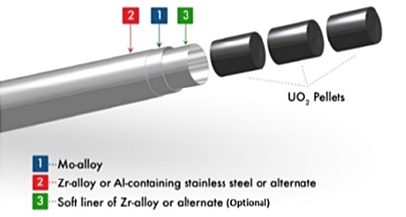
Fig. 1. Schematic of coated Mo-alloy cladding.